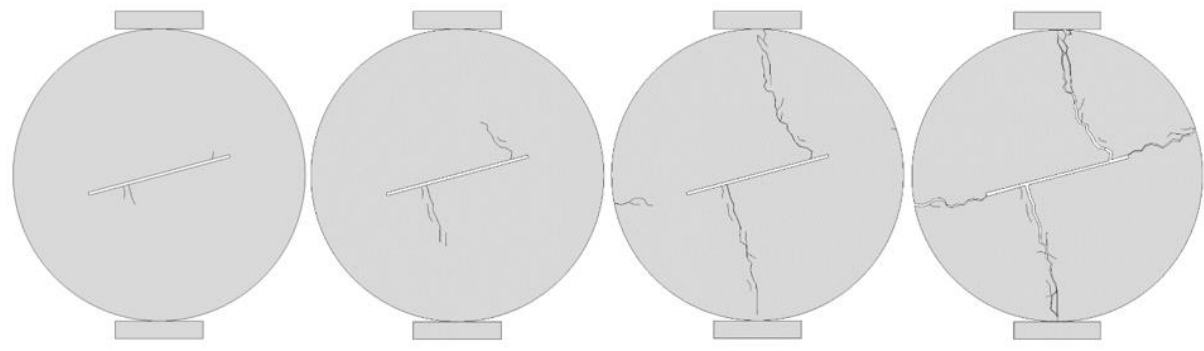
Figure 8. Fracture process for Brazilian disc with a crack of 75° angle.